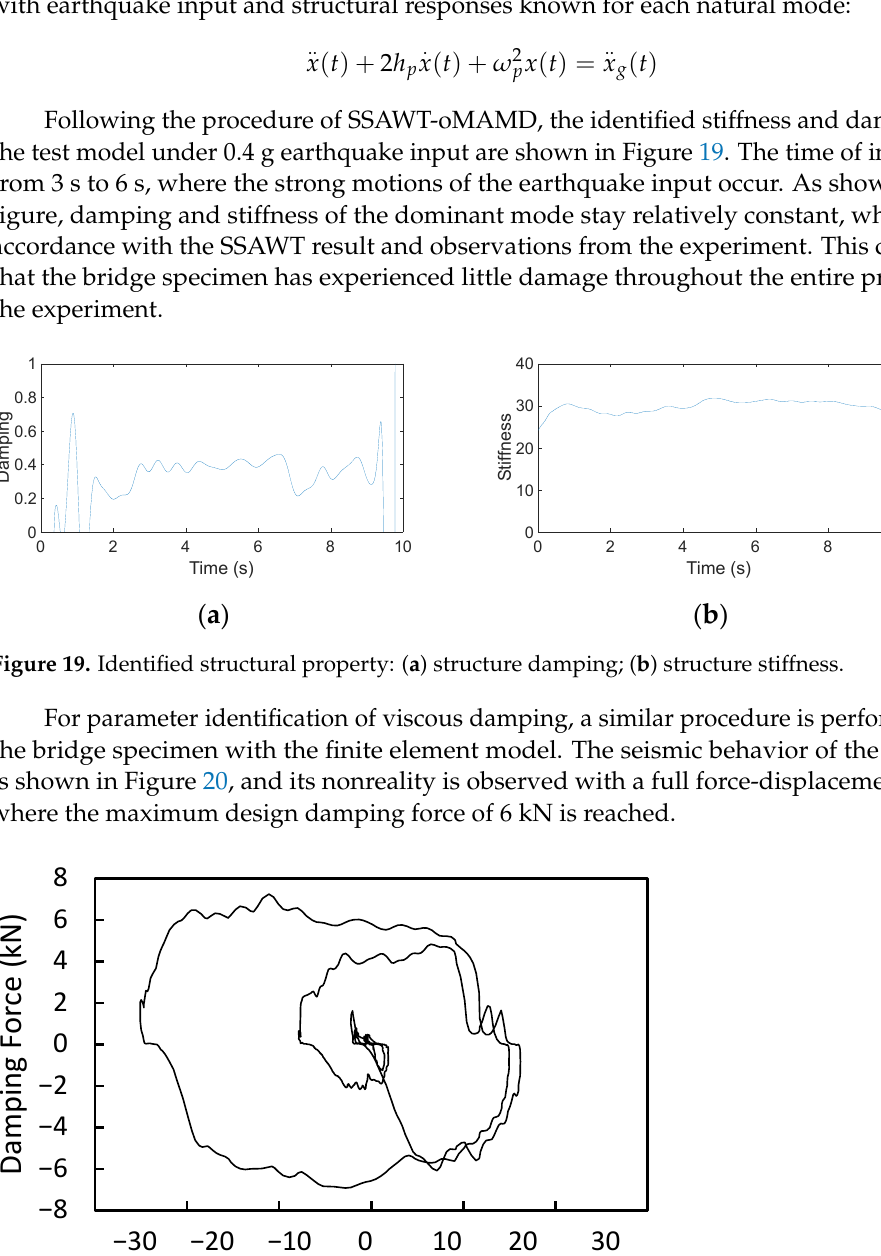
Figure 20. Seismic response of viscous damper. As shown in Figure 21, the damping coefficient can be identified with a maximum deviation of 2.7% from theoretic value. However, due to difference between numerical simulation and actual test performance (including manufacturing error and randomness of material), the identified damping coefficient of the test model has a larger error and a shorter identification period for